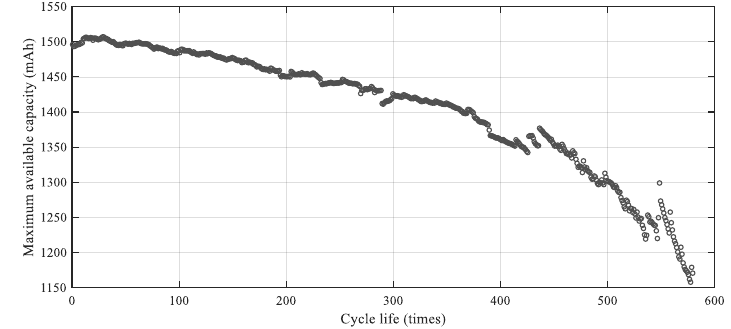
Figure 3. Cycle life vs. maximum available capacity.